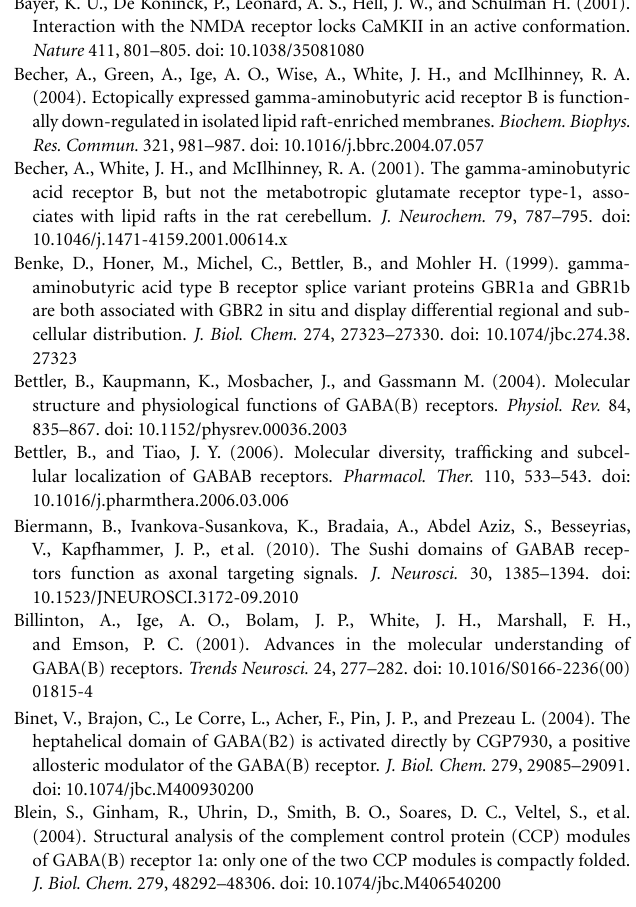
KCTD12, KCTD12b, and KCTD16). At the membrane, GABA B receptors have crosstalk with other receptors such as GABA A receptor, mGluR1, NMDA receptor, TrkB receptor and IGF-1 receptor. Both heterodimers and tetramers of GABA B receptors exist at the membrane. Dimers and dimers of GABA B receptors form tetramers through GABA B1 and GABA B1